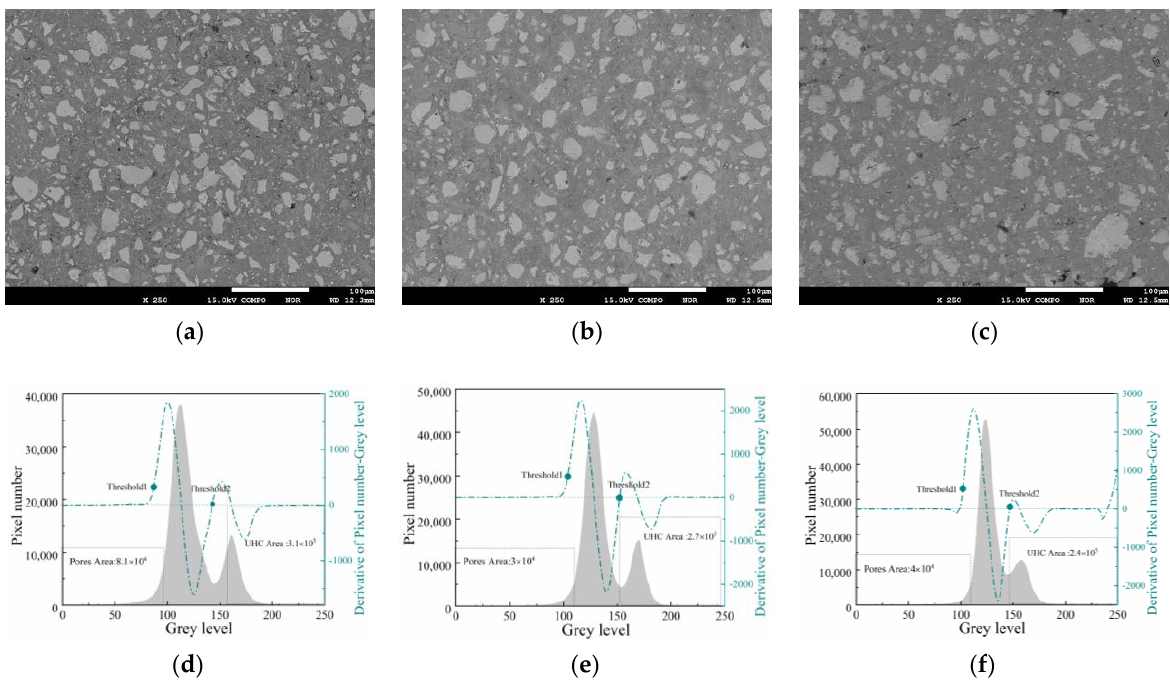
Figure 8. 28 d BSE image of cement mixture with nothing ( a ), CNA ( b ) and TEA ( c ); the gray histogram of cement mixture with nothing ( d ), CNA ( e ) and TEA ( f ).